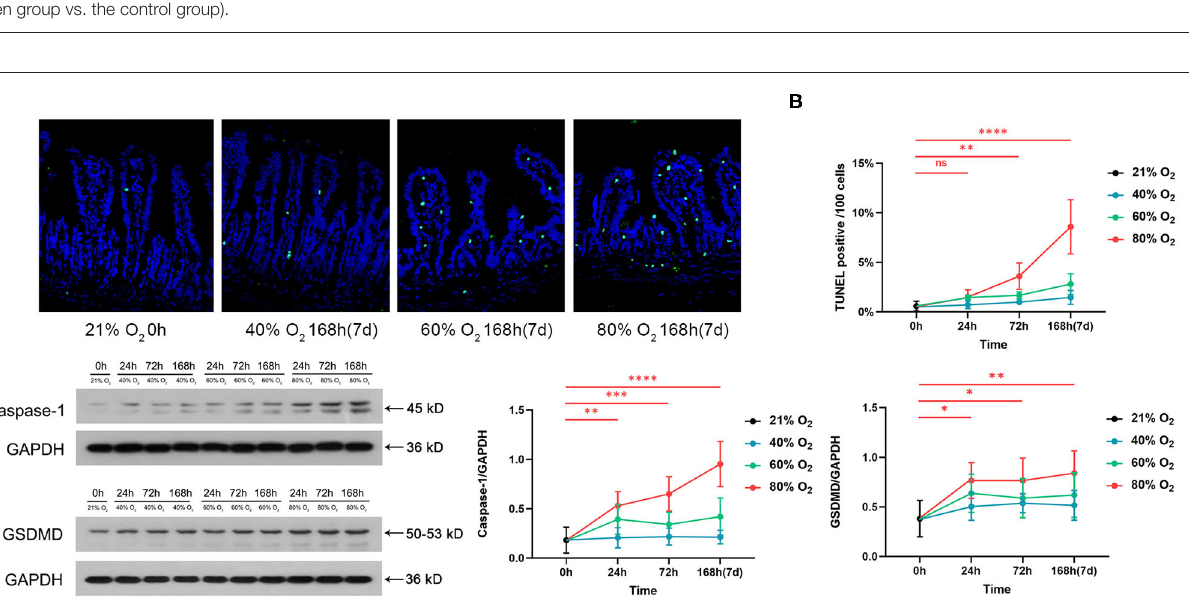
FIGURE 2 | Hyperoxia induces time- and dose-dependent enterocyte death ( n = 6). (A) Representative intestinal TUNEL staining sections from the control group and the oxygen groups (FiO 2 of 40, 60, and 80%) were exposed for 168h (7 days). (B) The graph of the number of apoptotic cells in the control and the oxygen groups. (C) Western blotting and the graphs of Caspase-1 and GSDMD levels in the control and the oxygen groups. TUNEL, TdT-mediated dUTP-biotin nick end labeling; GSDMD, gasdermin-D. * P < 0.05; ** P < 0.01; *** P < 0.001; **** P < 0.0001 ( P -values: 80% of oxygen group vs. the control group).